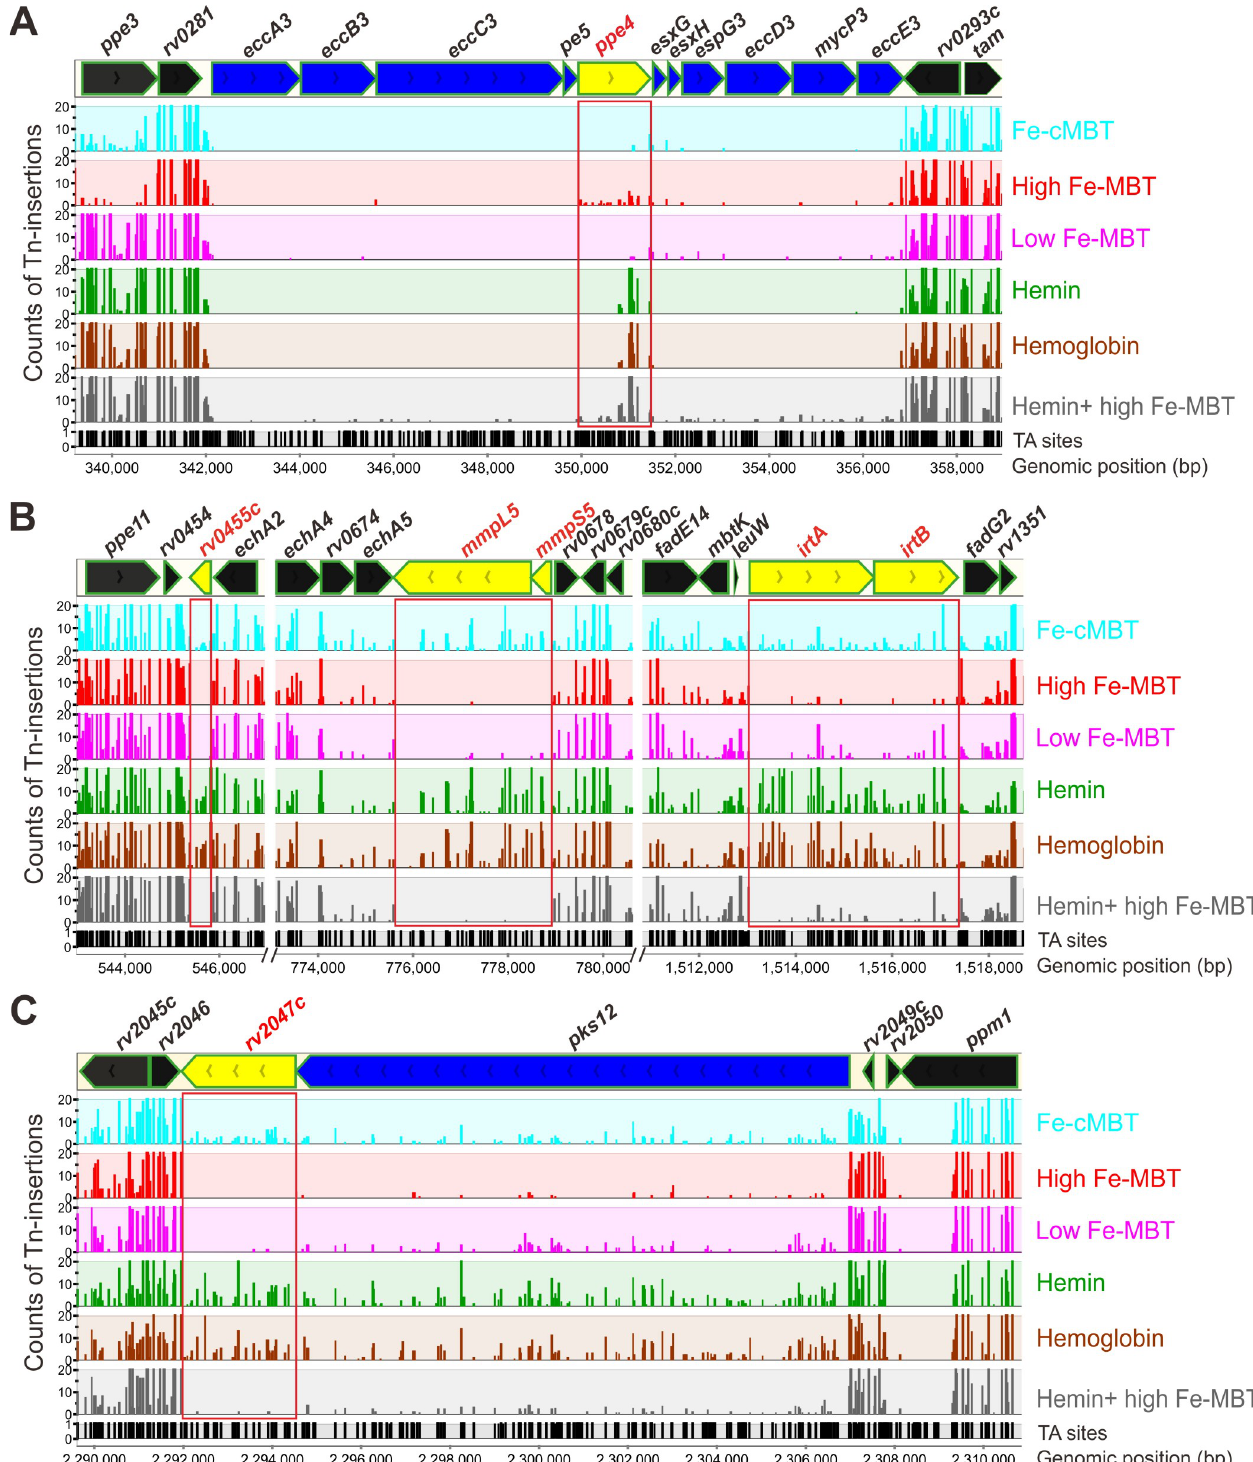
Fig 5. M . tuberculosis genomic regions involved in siderophore utilization. The distribution of the transposon insertions in Mtb genomic regions including esx-3 operon (A); rv0455c gene, mmpS5-mmpL5 operon, irtA-irtB operon (B); and pks12-rv2047c operon (C). The iron conditions are marked with different colors. The y-axis (0, 10, 20) represents the counts of the Tn-insertions and x-axis represents the genomic position (bp). Potential TA dinucleotide insertions sites are indicated. Regions containing genes of interest are highlighted by red boxes. Plots were generated using MochiView 1.46 [46].